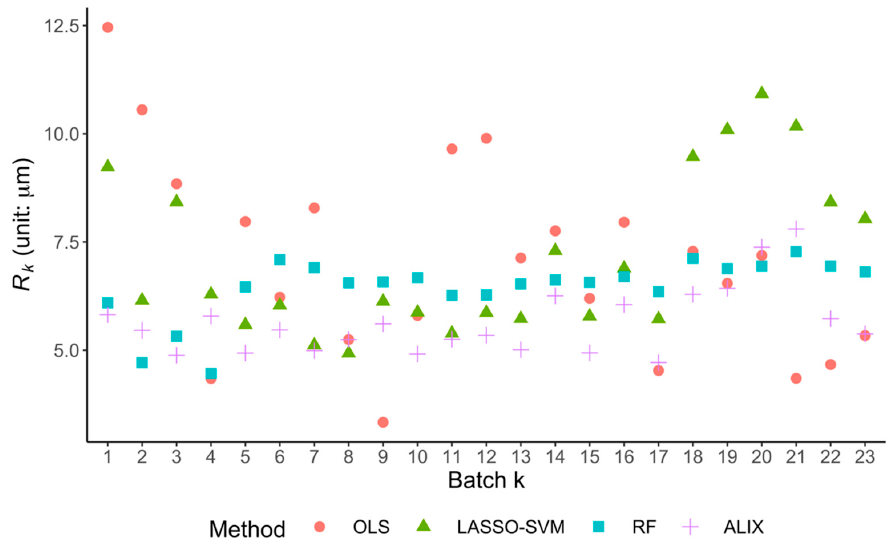
Figure 9. Results of R k for each model that is trained on batch k .